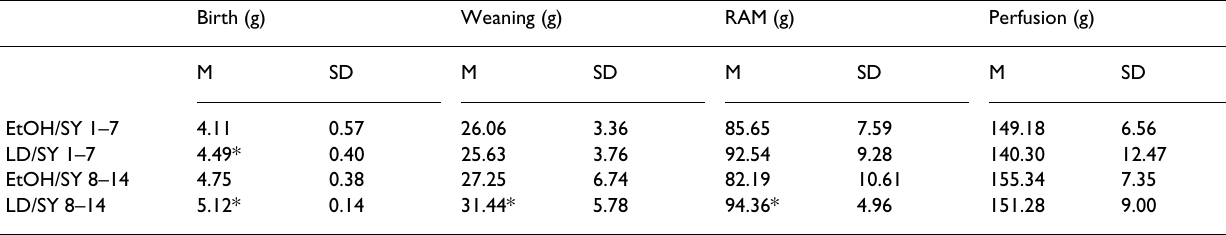
Table 5: Female Weight Data for selected EtOH/SY and LD/SY weekly treatment groups. Birth (g) Weaning